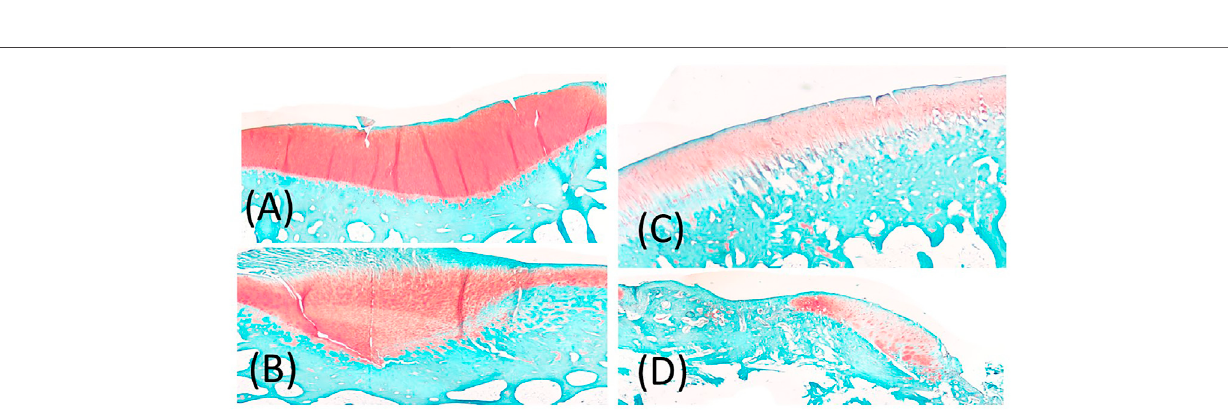
FIGURE 4 | (A) representation of Score 1 = small spaces < 50% of the length of condyle or plateau, (B) representation of 2 or 3 score depending on 2 = Moderate spaces/somesplits < 50%ofthelength,3=moderatespaces/splits > 50%ofthelength, (C) 4=numeroussplits < 50%ofthelength, (D) 5=numeroussplits > 50%ofthe